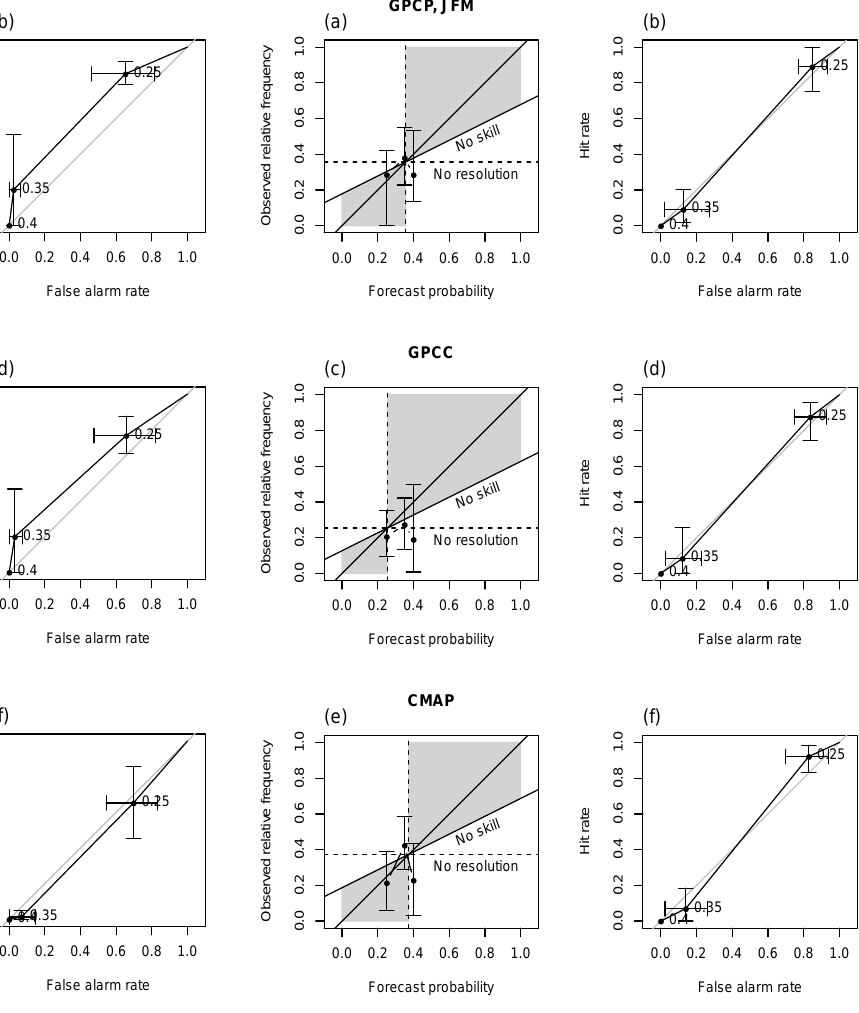
Figure 4. The attributes diagrams and the ROC curves for late season forecasts, based on different data sets for verification. The confidence intervals are calculated using the block bootstrap ( n =